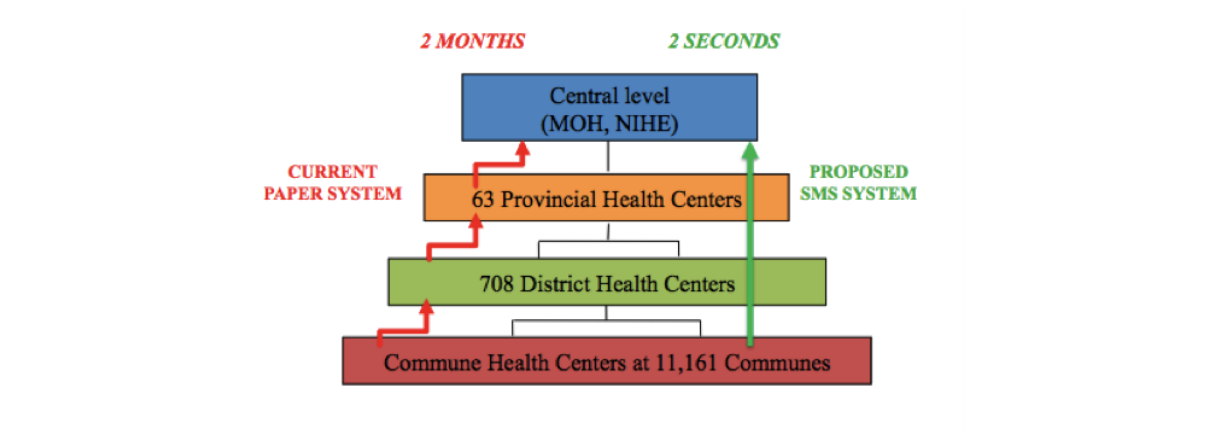
Figure 1. The flow of infectious disease information through the current paper-based reporting system (left-hand side) and the proposed SMS text message-based reporting system (right-hand